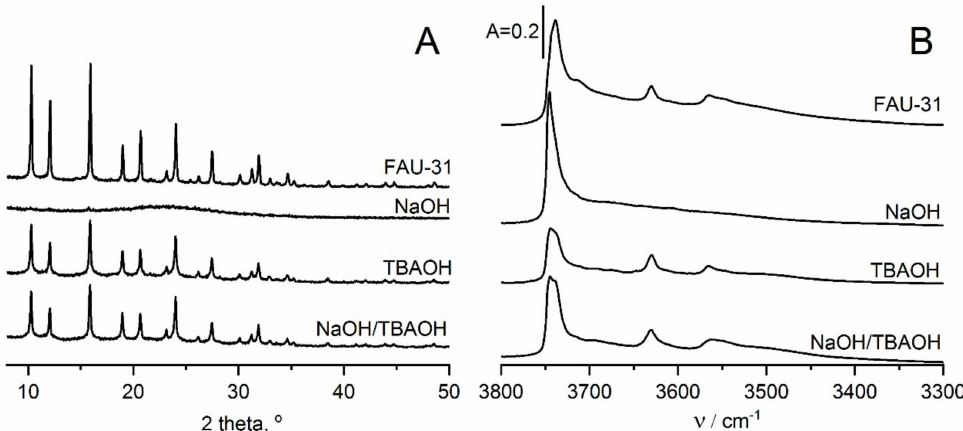
Figure 2. X-ray di ff raction (XRD) diagrams ( A ) and the infrared (IR) spectra ( B ) of OH groups in zeolites FAU-31 parent and desilicated in NaOH, TBAOH and NaOH / TBAOH. Figure adapted with the permission from